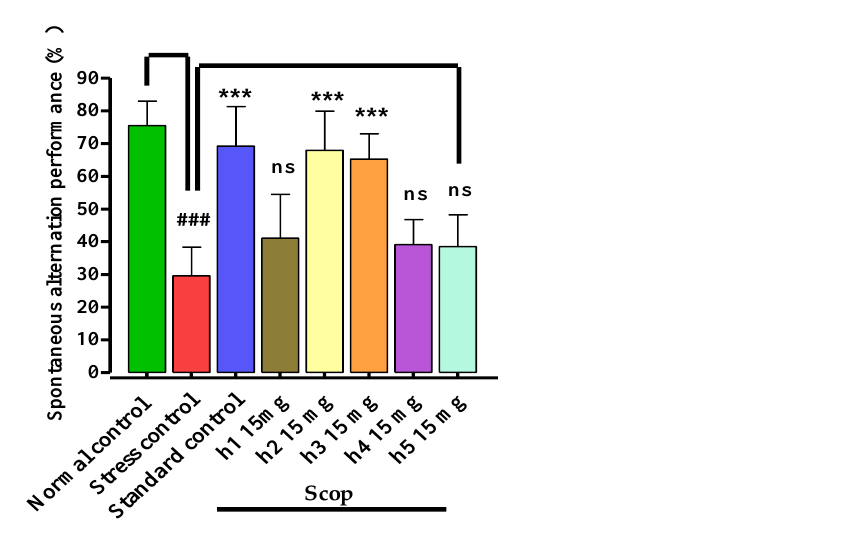
tion performance in Y-maze behavioral mouse model. Results are shown as mean ± SD, n = 8.